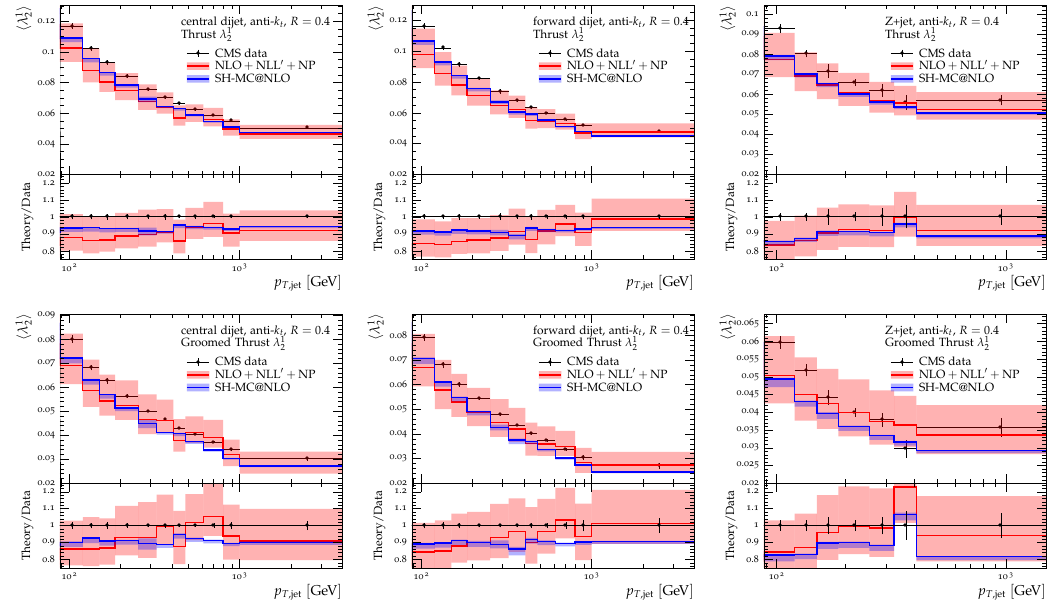
Figure 16. Same as figure 14 but for the mean values of jet thrust, i.e. h λ 1